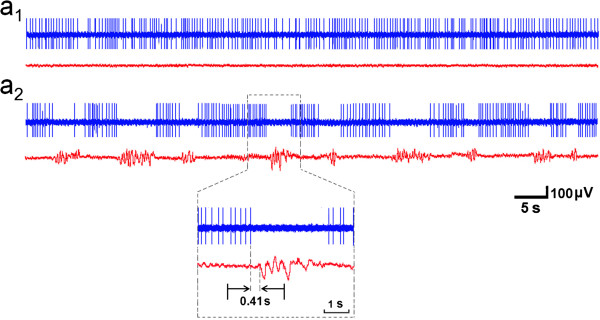
Representative EEG tracing and firing of the NTS in one rat. In (a1) and (a2), the upper signal was the firings of the NTS neuron, the lower signal was EEG tracing. (a1) Before PTZ, (a2) After PTZ, Magnification: the decreasing of the firing rates of the NTS neuron was accompanied by an epileptic discharge in EEG tracing with 0.41 s delay.